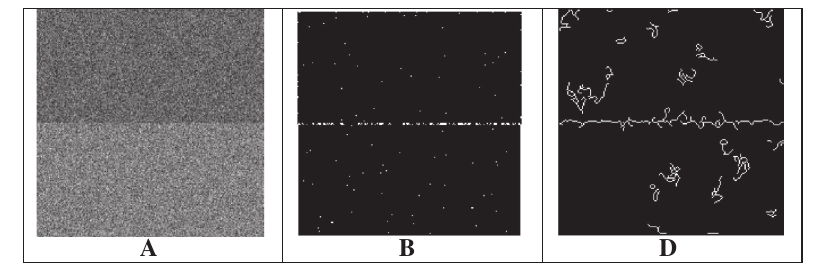
Figure 7. Edge Detection for a Special Image.